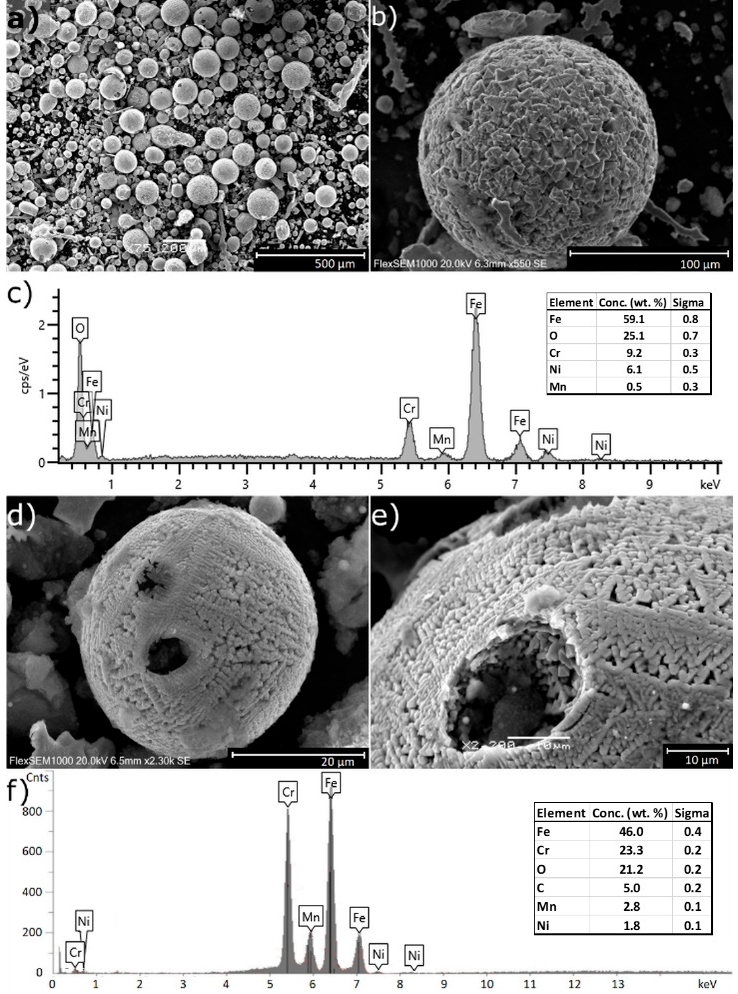
Figure 4. SEM microstructure images of the powder waste material after laser cutting process: ( a , b , d , e ) examples of particles with corresponding EDS spectra collected from ( c ) surface and ( f ) particle